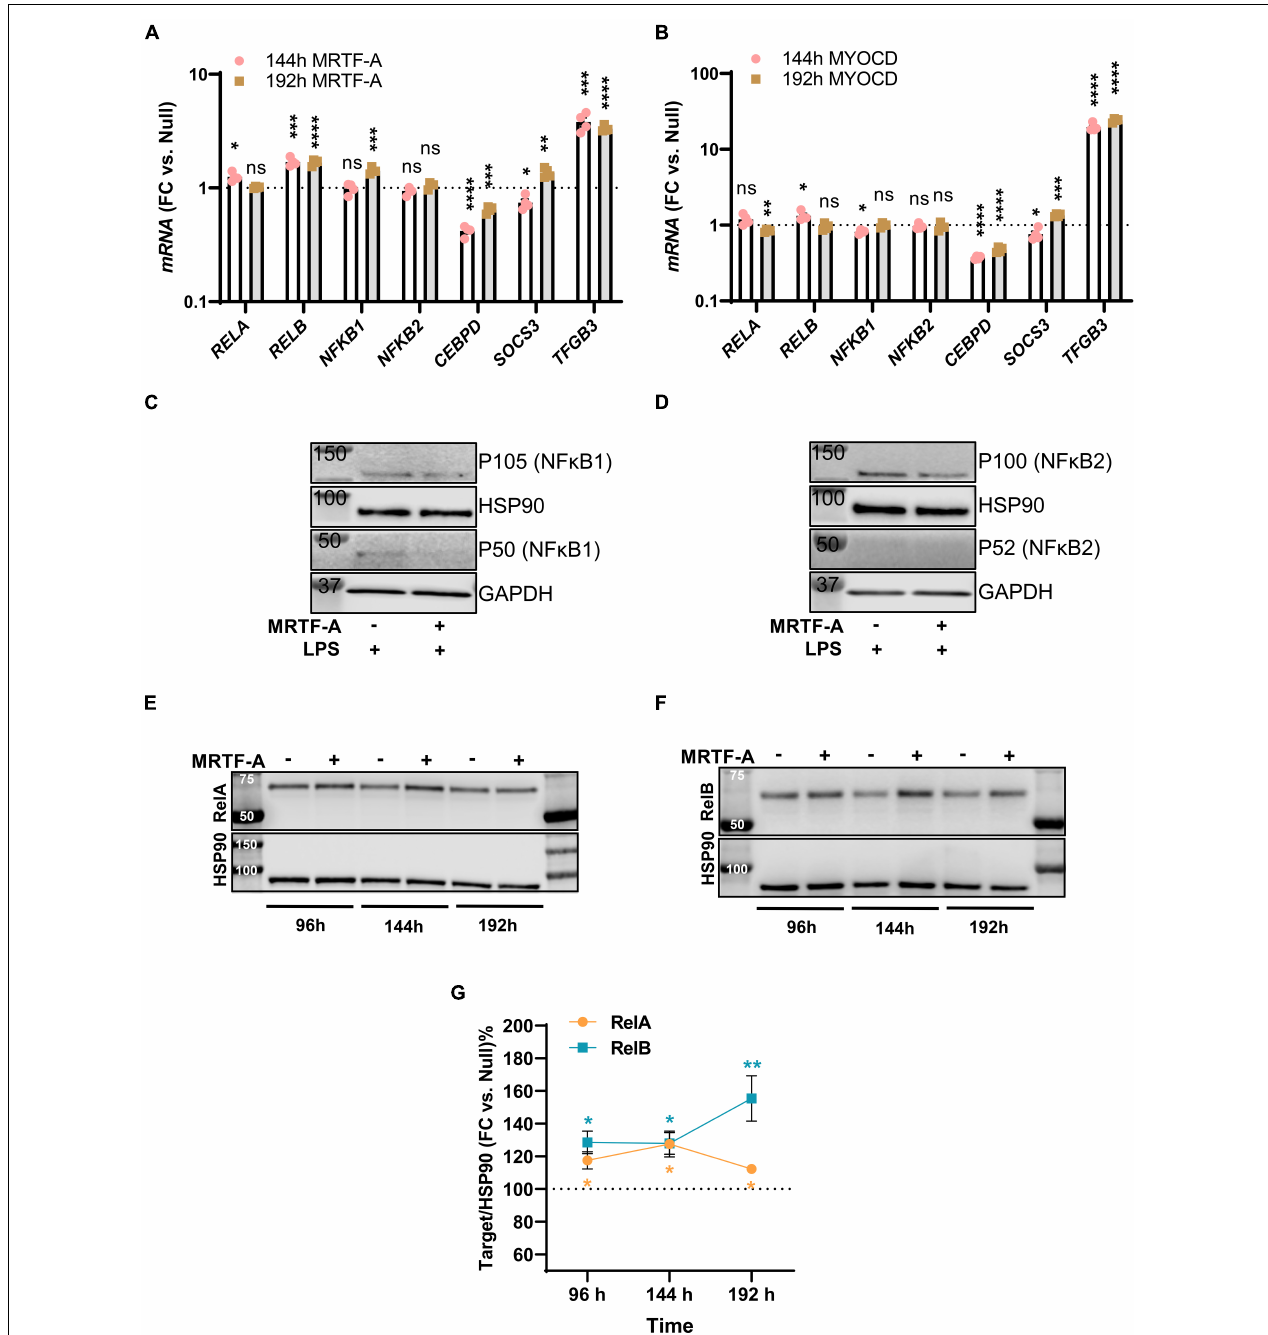
FIGURE 4 | Only modest remodeling of the inflammatory apparatus by MRTF-A. Transcripts of possible relevance for inflammation were identified in an RNA-seq experiment where MYOCD was overexpressed in human coronary artery smooth muscle cells. These transcripts were then examined by RT-qPCR at two different times of overexpression of MRTF-A (A) and MYOCD (B) , respectively. (C,D) Show western blots after treatment with null virus and MRTF-A virus in the presence of LPS. The only consistent differences observed by western blotting were modest increases of RelA (E,G) and RelB (F,G) . * P < 0.05, ** P < 0.01, *** P < 0.001, **** P <